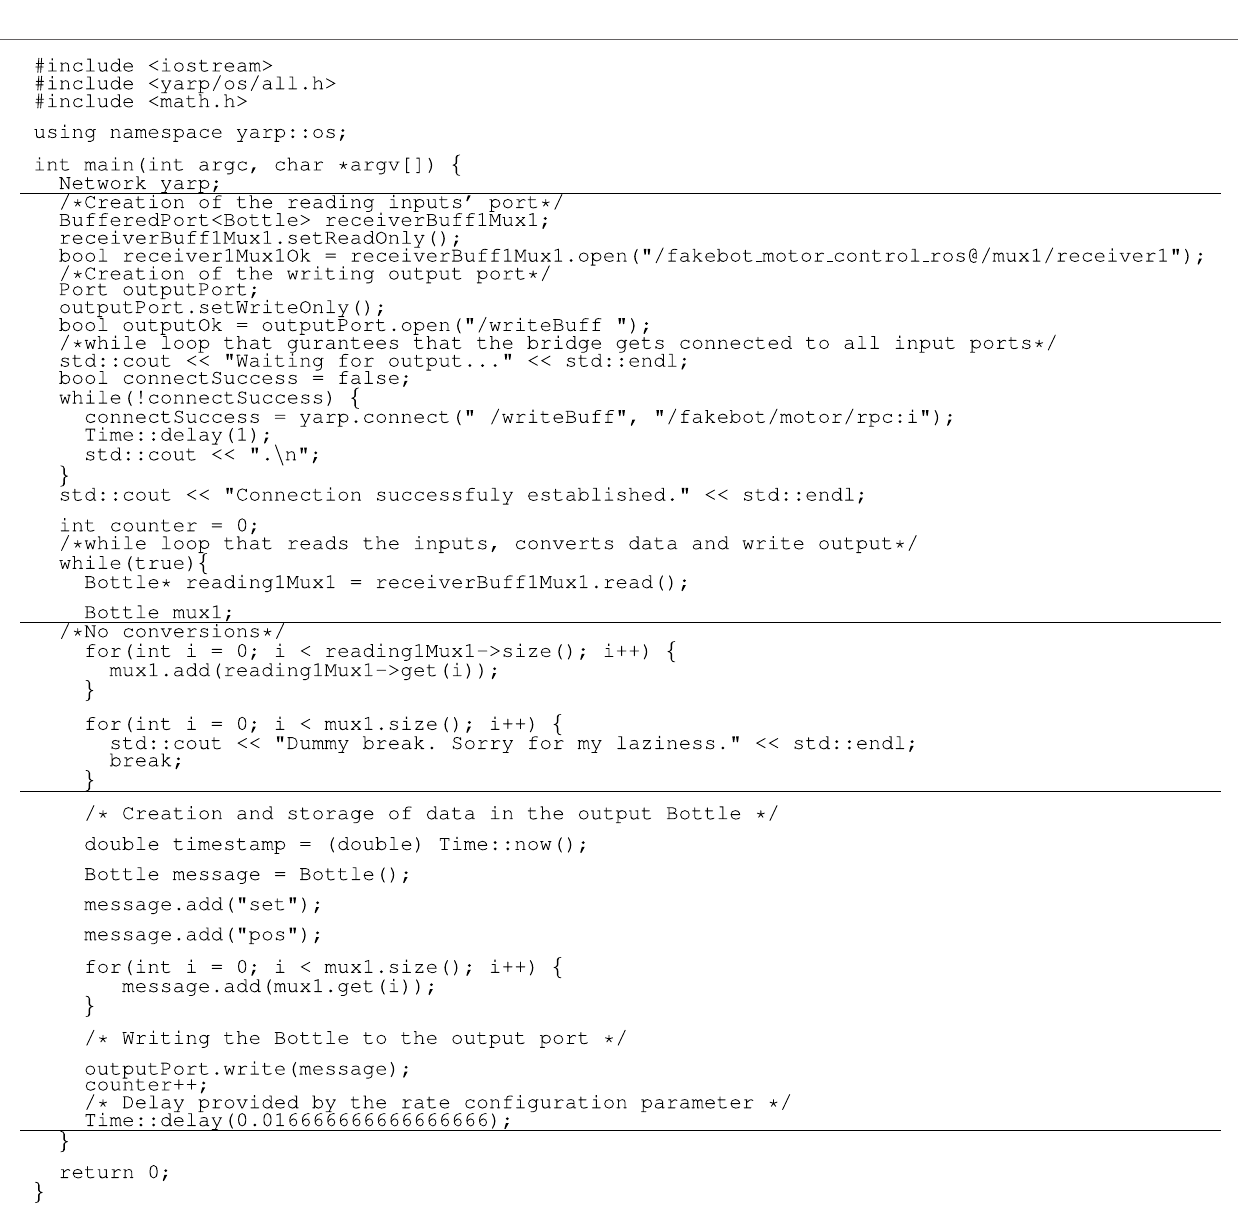
FIGURe 4 | example of the generated C ++ code by running the yarp-bottle-generator executable with the configuration file ros_yarp_tutorial example in Figure 2B